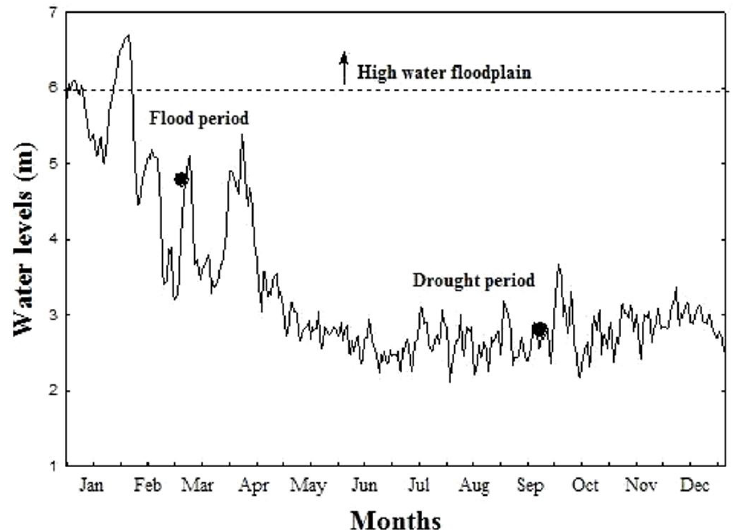
Figure 2. Fluviometric level of the Paraná River in 2010. The circles represent the collection periods. Fluviometric levels exceeding the upper dashed line represent bank